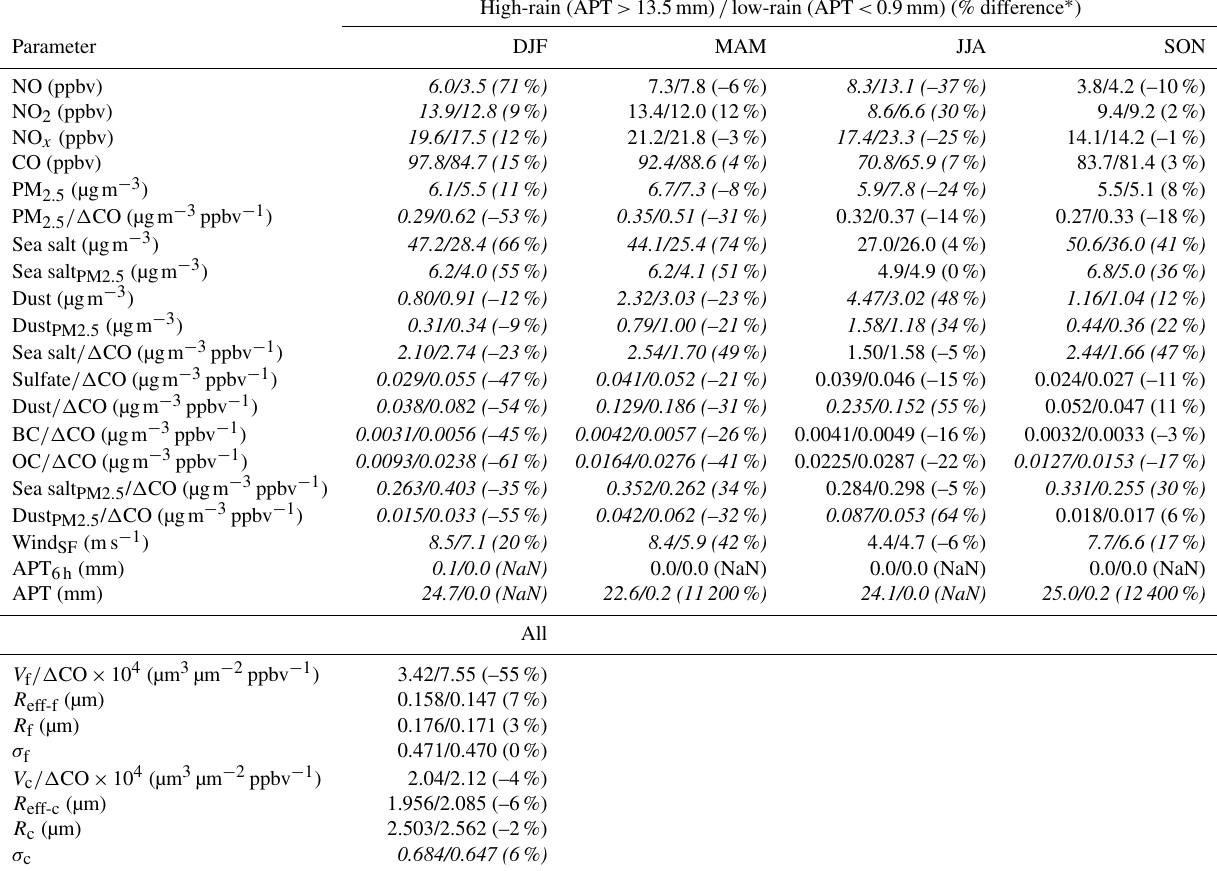
Table 2. Seasonal medians of aerosol, gas, and meteorological variables for Cluster 1 divided into high- and low-APT categories. Differences in median values that are statistically significant ( p value < 0.05) based on a Wilcoxon rank-sum test are highlighted with italic font. Per- centage differences ∗ between high- and low-APT median values are provided in parentheses. NO, NO 2 , NO x , and PM 2 . 5 are based on Fort Prospect measurements, whereas all other parameters are from MERRA-2 with the exception of the two APT rows (derived from HYSPLIT and GDAS) and the last eight rows corresponding to AERONET volume size distribution data. We combined all seasons for AERONET data to have sufficient statistics for comparisons (high APT 16 points, low APT 19 points). AERONET parameters include volume concentration ( V ), effective radii ( R eff ), volume median radii ( R ), and geometric standard deviation ( σ) with subscripts f and c for fine and coarse modes, respectively. The number of data points for each table entry is summarized in Table